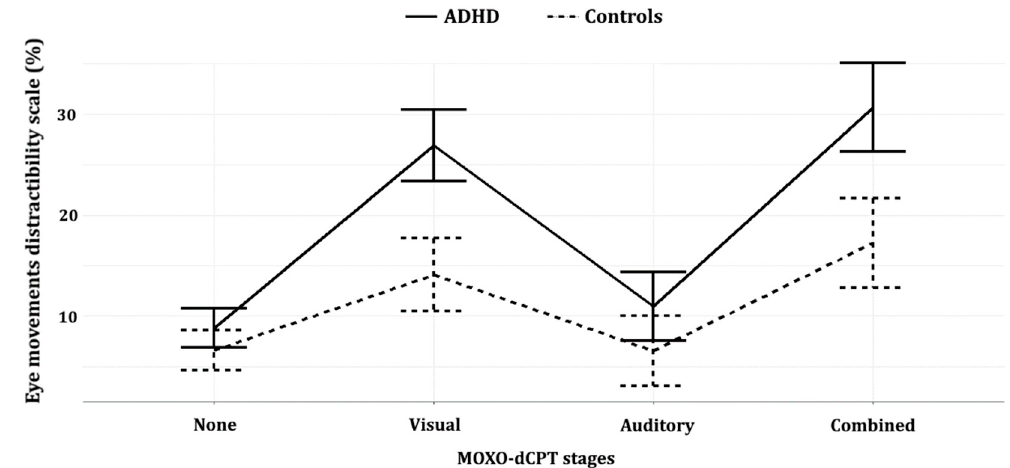
Table 3. Two-stage hierarchical logistic regressions ( N = 85), for all MOXO-dCPT stages and the visual distractors stage. The first model includes the four conventional indices and the second model adds the eye movement distractibility scale.